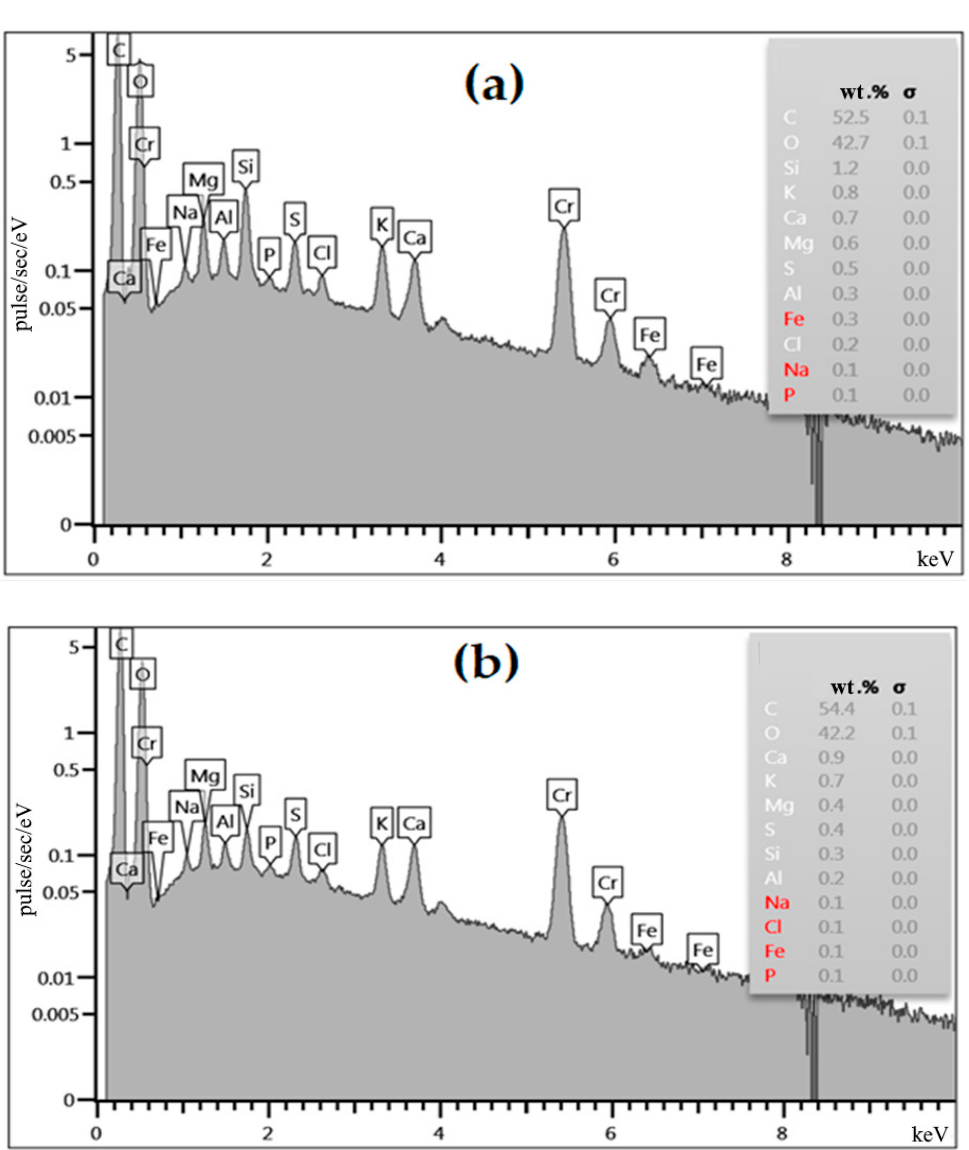
Figure 6. Energy-dispersive spectrum of the original ( a ) and fired biomass of apricot kernel shells at 250 °C ( b ). 250 ◦ C ( b